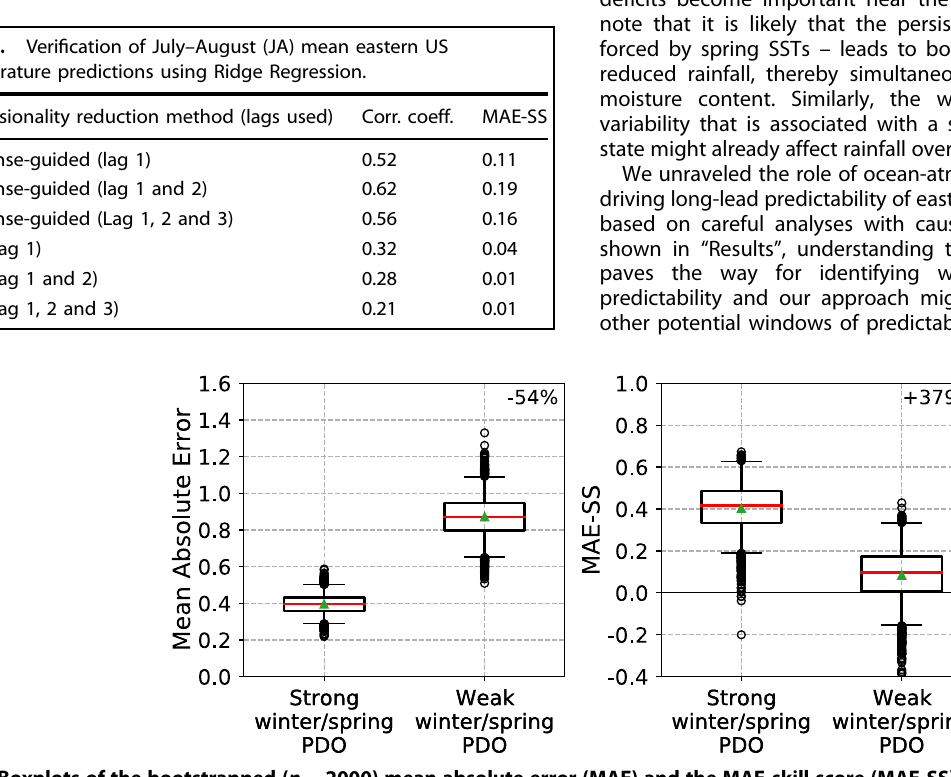
Fig. 7 Boxplots of the bootstrapped ( n = 2000) mean absolute error (MAE) and the MAE-skill score (MAE-SS) calculated for two different sub-sets. The strong PDO sub-set contains 21 (50%) years with the most anomalous DJFMAM mean PDO states. The weak PDO sub-set contains the other 21 years. The whiskers indicate the 95% con fi dence intervals, data outside the con fi dence interval are shown as outliers, red line shows the median, black line shows the quartiles, and the green triangle shows the